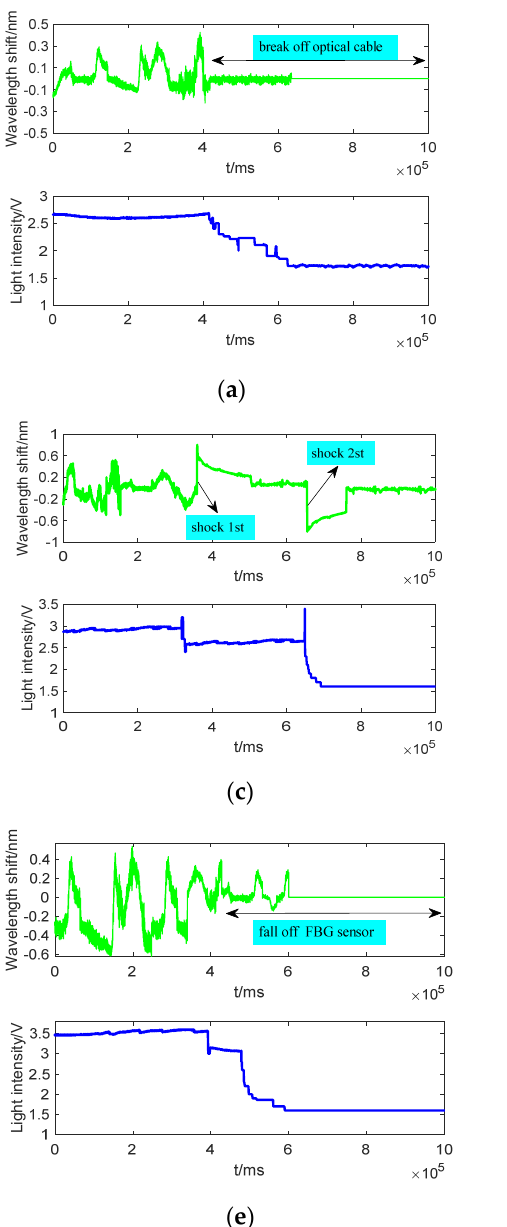
Figure 8. Wavelength and light intensity variation curves of five typical faults. ( a ) Break off the optical cable. ( b ) Bending the optical cable. ( c ) Shock test. ( d ) Sudden power off and power on. ( e ) Fall off FBG sensor.